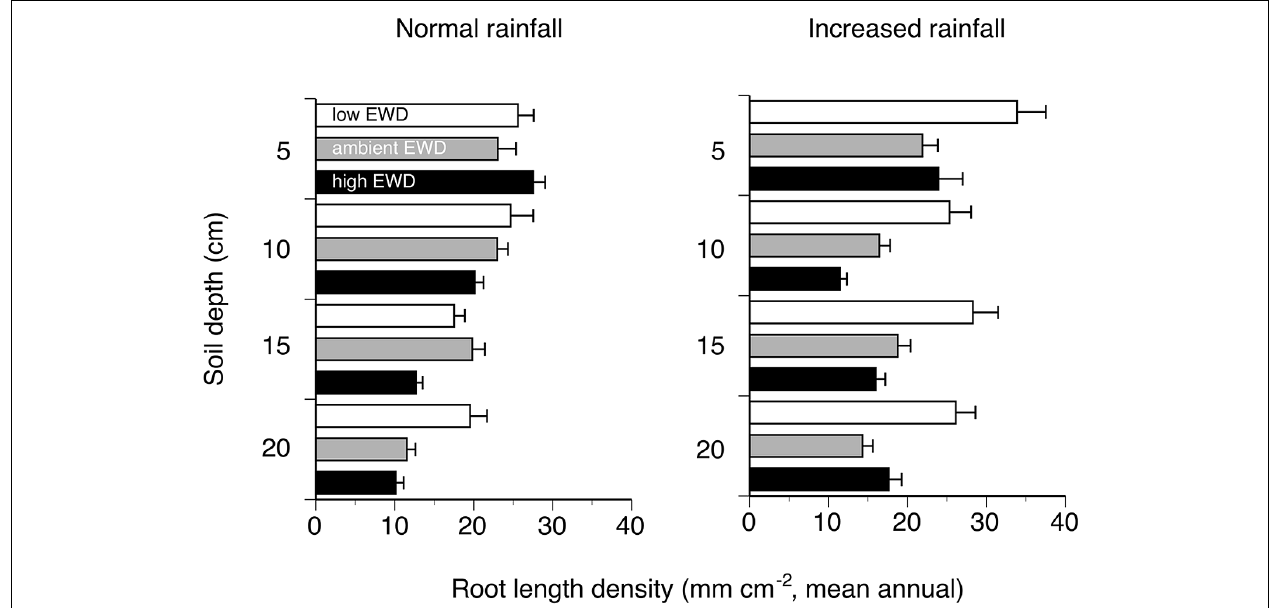
FIGURE 2 | Mean annual root length density in different soil depths measured using minirhizotrons (0–20 cm topsoil, one 60 cm long tube per plot) in trenched grassland plots with manipulated earthworm